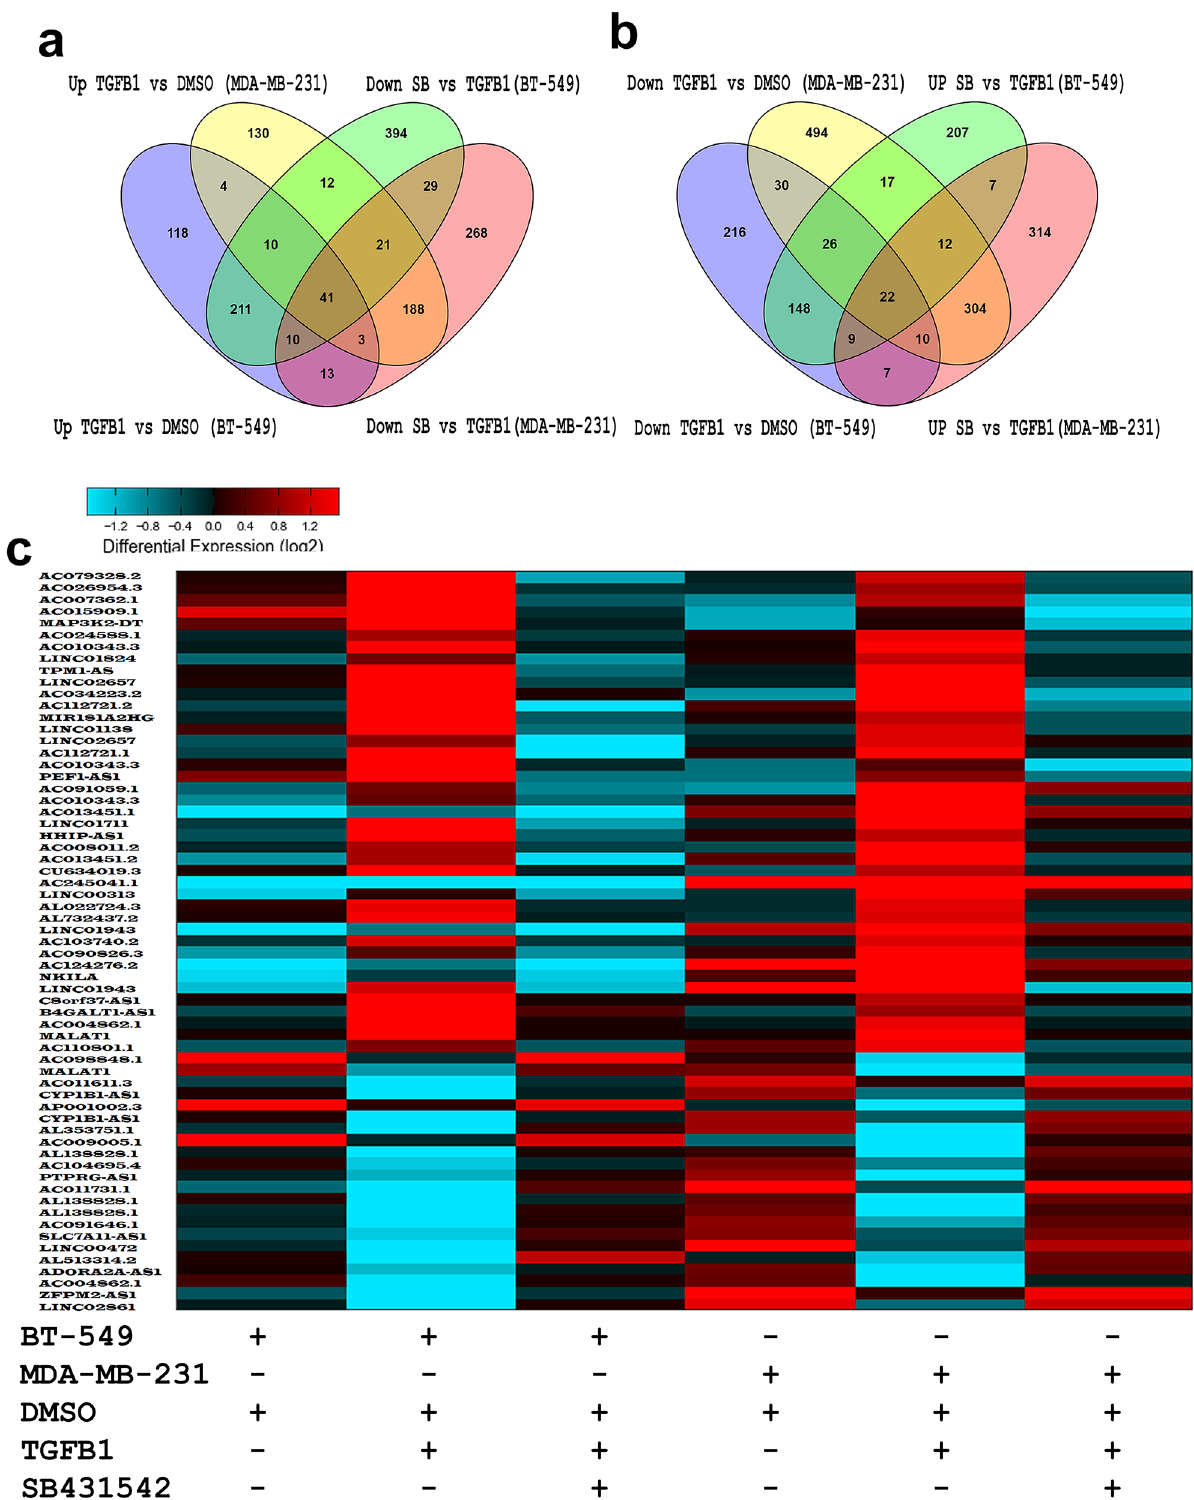
Figure 4. Venn diagraph depicting the overlap in upregulated ( a ) or downregulated ( b ) lncRNAs in BT-549 and MDA-MB-231 under the indicated experimental conditions. Upregulated genes are defined as the genes upregulated (FC ≥ 2.0) by TGFB1 and those were downregulated (FC ≤ 2.0) by SBSB431542. Downregulated genes were defined as the genes downregulated (FC ≤ 2.0) by TGFB1 and those were induced (FC ≥ 2.0) by SB431542. ( c ) Heatmap depicting commonly altered (up and down) lncRNAs under different experimental